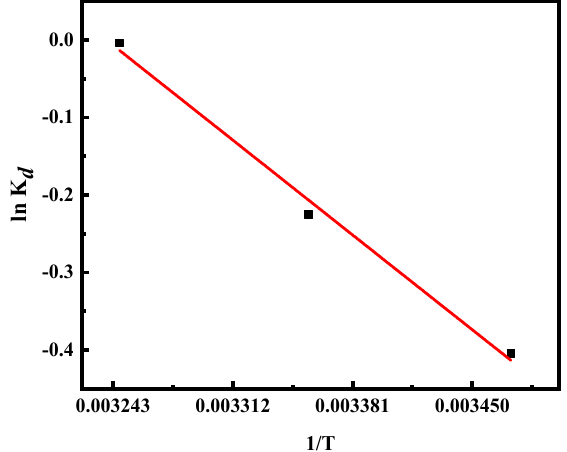
Figure 8. Thermodynamics plot for adsorption of Cr(VI) by MHDB. Table 3. Thermodynamic parameters for adsorption of Cr(VI) by MHDB. Reaction